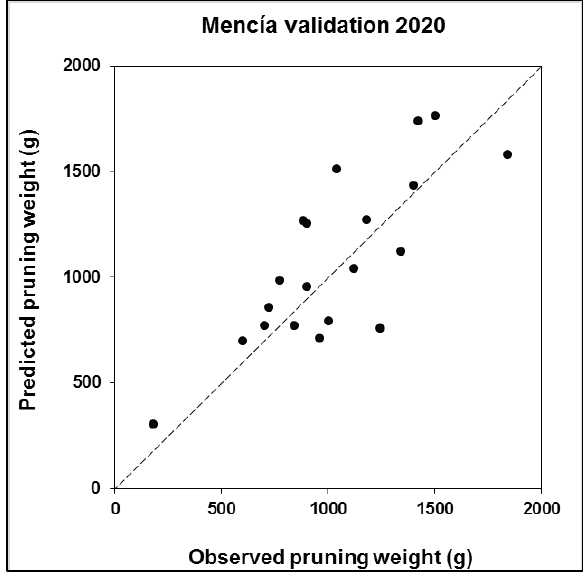
Figure 4. Predicted vs. observed pruning weight for the Mencía vineyard validated with independently collected data (dashed line = 1.1).